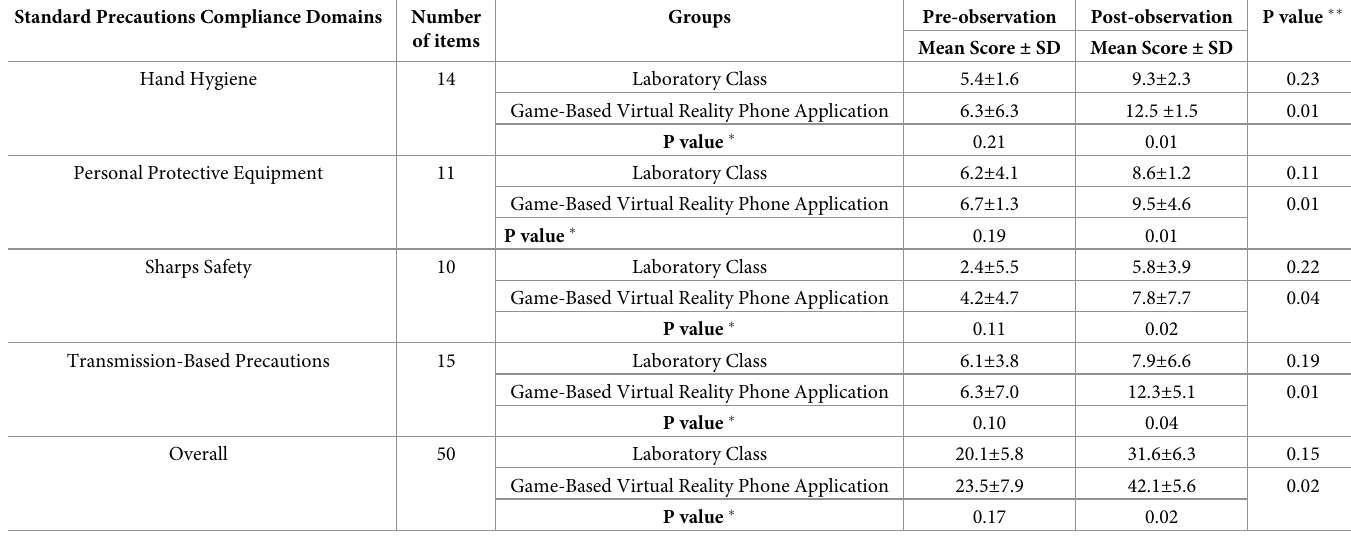
Table 3. Comparison of standard precautions compliance domains means scores of the laboratory class and the game-based virtual reality phone